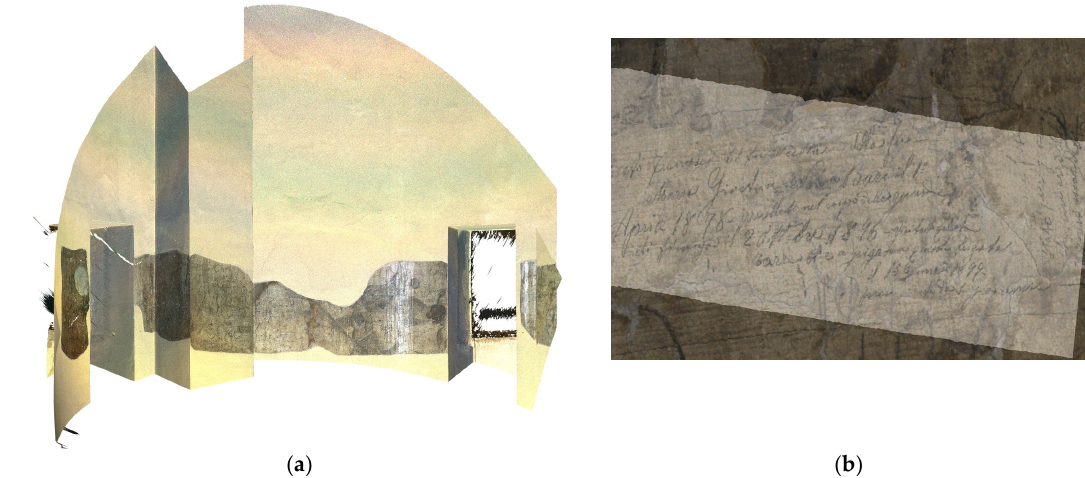
Figure 13. Tower room of the Saint Sebastian Gate: ( a ) image of part of the 3D model of the room; ( b ) detail of background removal elaboration for the reconstruction of inscriptions’ contents [48]. (Elaboration carried out by ENEA team with the custom software itrAnalyzer).